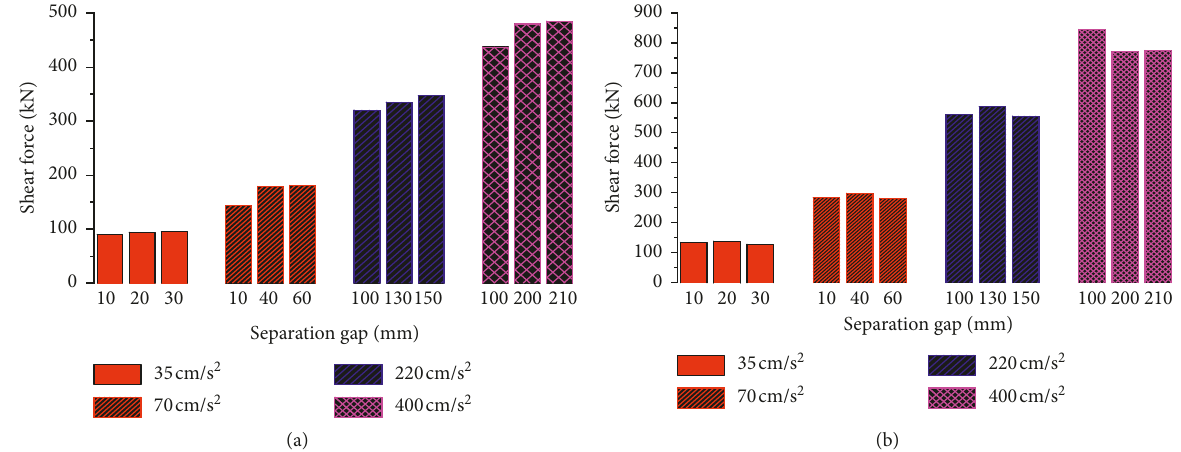
Figure 28: Base shear force history for J